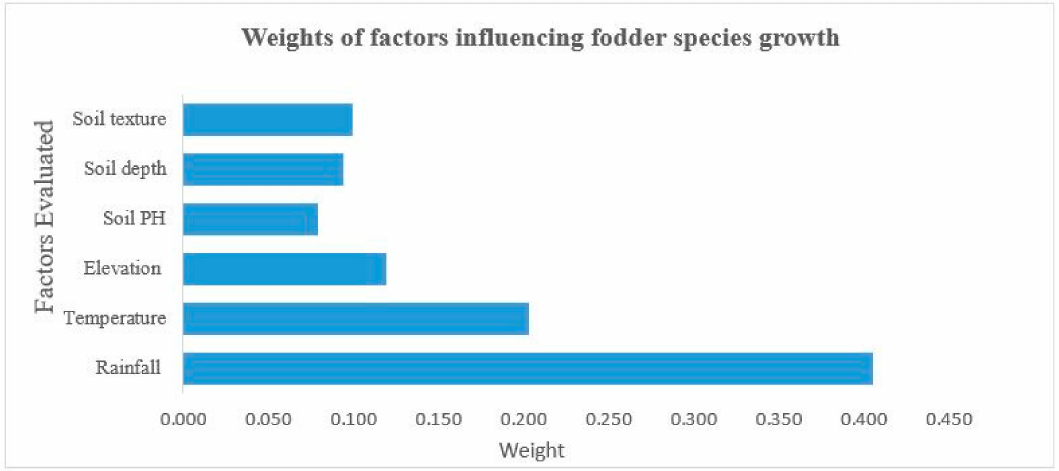
Figure 3. Rank of factors subjected to an analytical hierarchy pairwise comparison procedure to evaluate land for fodder growth